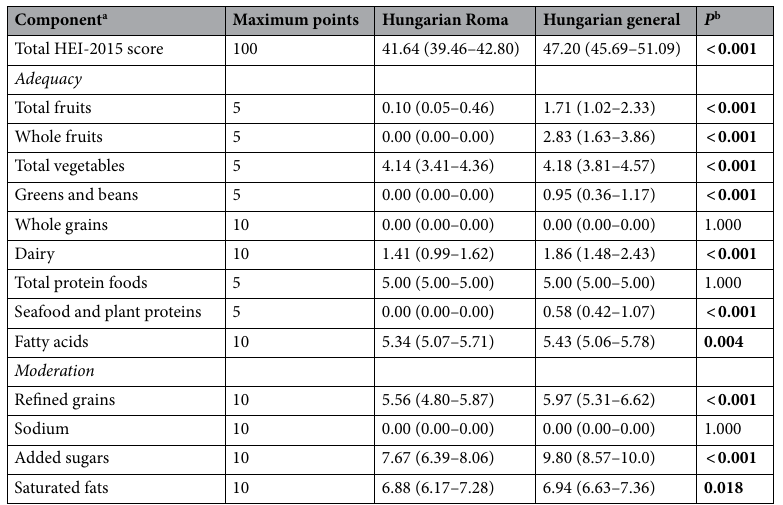
Table 5. Estimated median Healthy Eating Index-2015 scores adjusted for age, sex, educational status, and perceived financial status by quantile regression. a Values are medians (25th–75th percentiles). Median values of components may not add up to median total HEI scores. b Differences in median scores were evaluated by Independent-Samples Mann–Whitney U test. Bold values represent significant